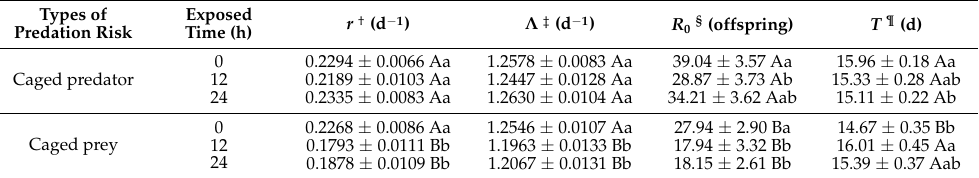
Figure 3. The age-specific survival rates ( l x ), age-specific fecundity ( m x ), and net maternity ( l x m x ) of Sitobion miscanthi reared under predator Coccinella septempunctata risk at different exposure times (0, 12, and 24 h) with either the caged predator or caged prey treatments. Table 4. The effects of the predation risks on the population parameters of Sitobion miscanthi . Values are mean ±